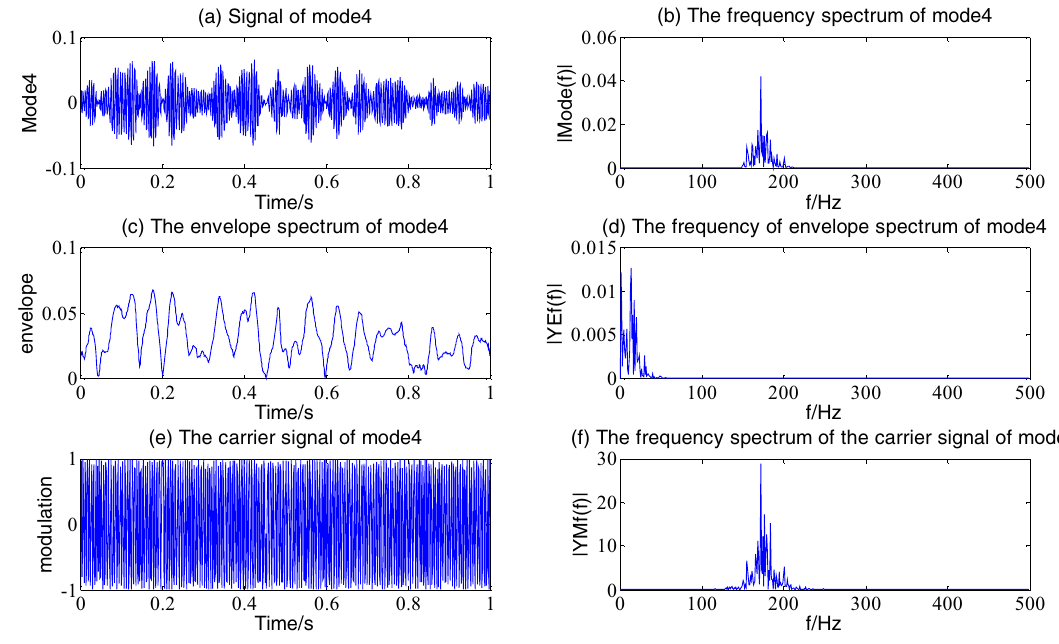
Figure 14. The envelope demodulation distribution diagram of mode4.